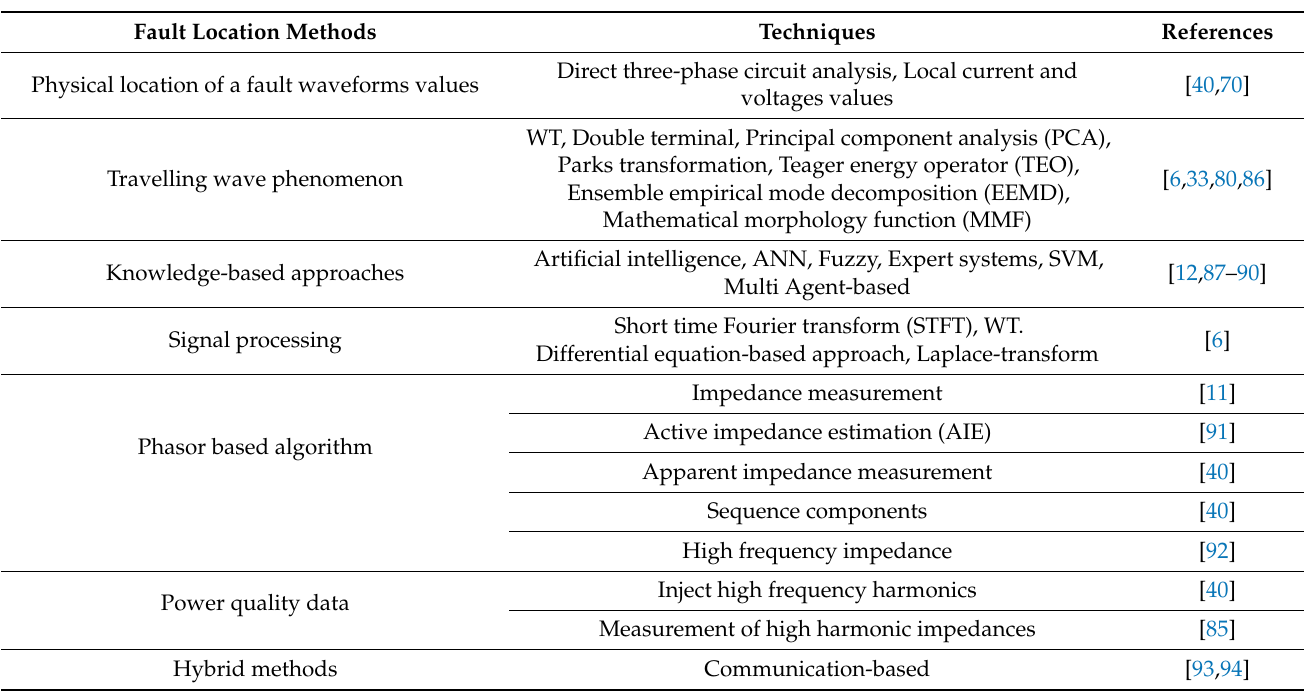
Table 2. Fault location methods and